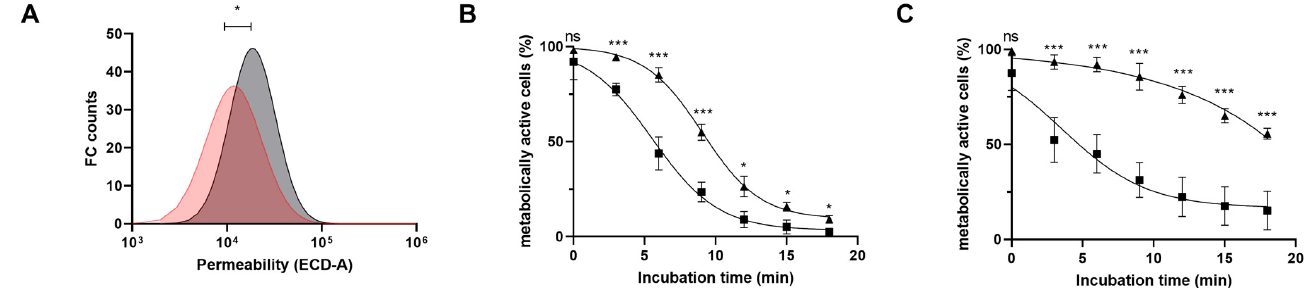
Figure 7. Cell permeability and acid sensitivity profile of B. longum NCC 2705 grown on glucose or galactose. ( A ) shows the propidium iodide (PI) stained cells distribution of mid-exponential phase harvested glucose (grey) or galactose (red) grown B. longum NCC 2705. Acid sensitivity profile of B. longum NCC 2705 grown on glucose (squares) or galactose (triangles) when exposed to pH 2.9 is depicted in ( B , C ). The loss of metabolically active cell populations (as reflected by the loss of esterase activity; changing from CFDA+ to CFDA − ) collected from exponentially ( B ) or the stationary ( C ) phase of growth is represented by the average and standard deviation of biological triplicates. Logistic growth modelling was applied to each curve of CFDA − population (r 2 > 0.90) and inversed data were plotted. Stars represent the adjusted p -value ( p -value; ns > 0.05, * p < 0.05; *** p < 0.001) obtained upon multiple unpaired t -test for each time